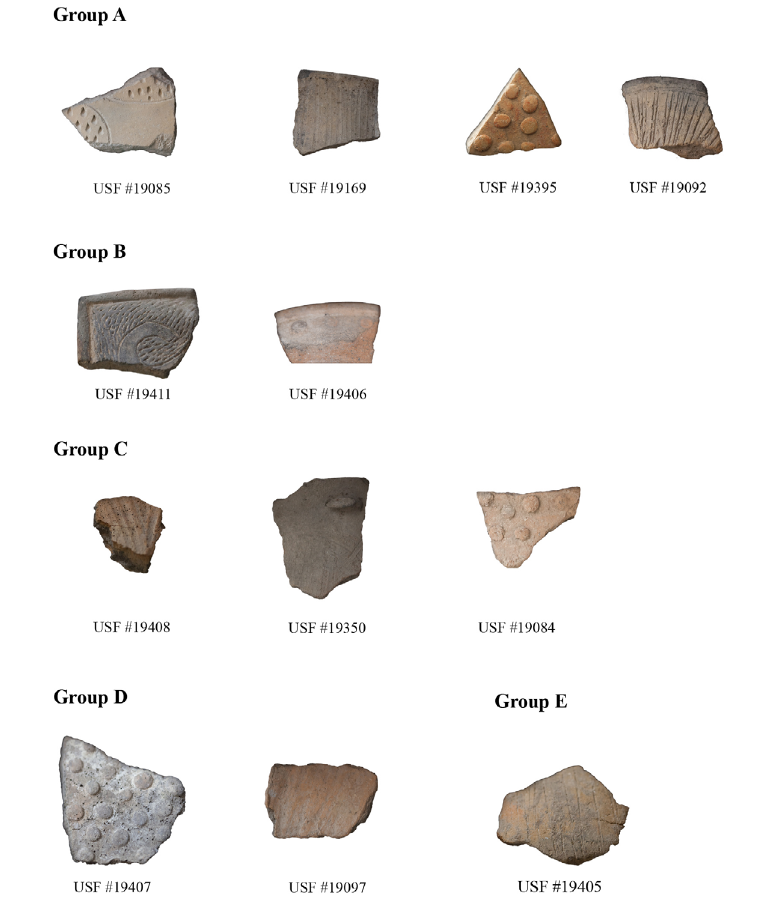
Figure 7. Selection of sherd examples from the Tarxien phase and group assignments based on the principal component analy- sis depicted in Figure 3 (Not to scale). Sherds Photograph by Fred